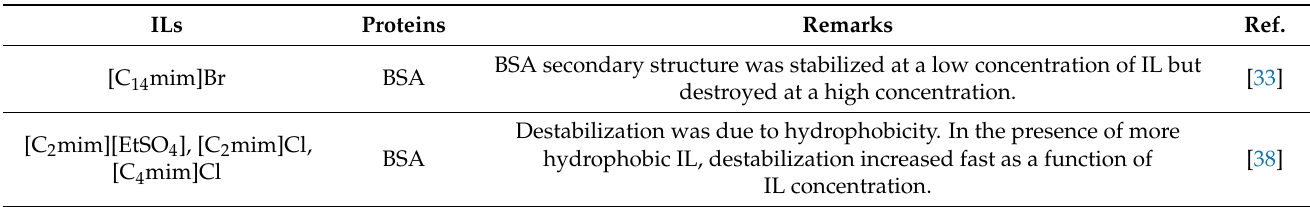
Table 1. Summary of the works reporting the stabilization of proteins in